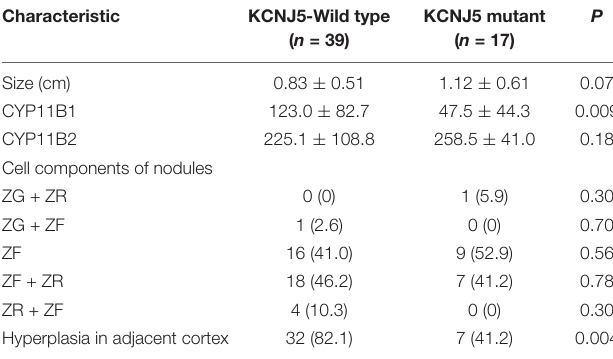
TABLE 2 | Characteristics of 56 nodules with and without KCNJ5 mutations in 24 patients with primary aldosteronism